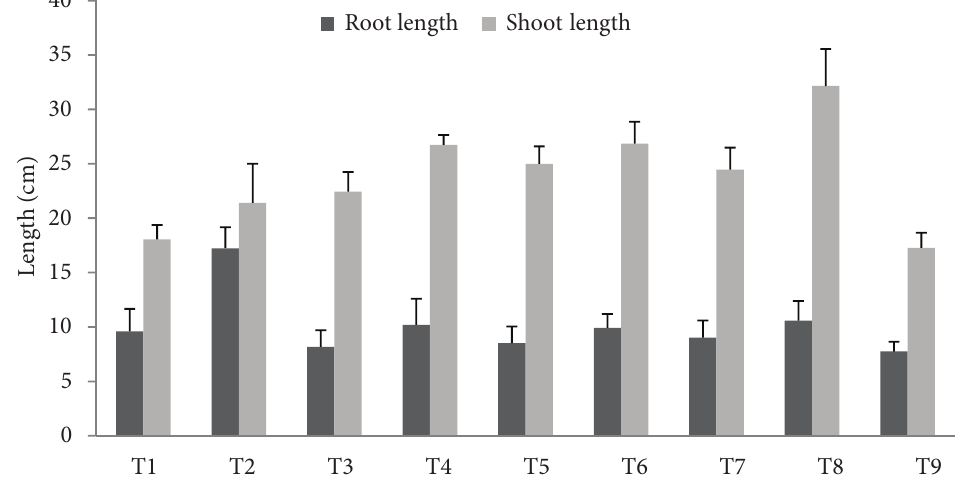
Figure 3. Effect of rhizobacteria on average root and shoot length per host plant